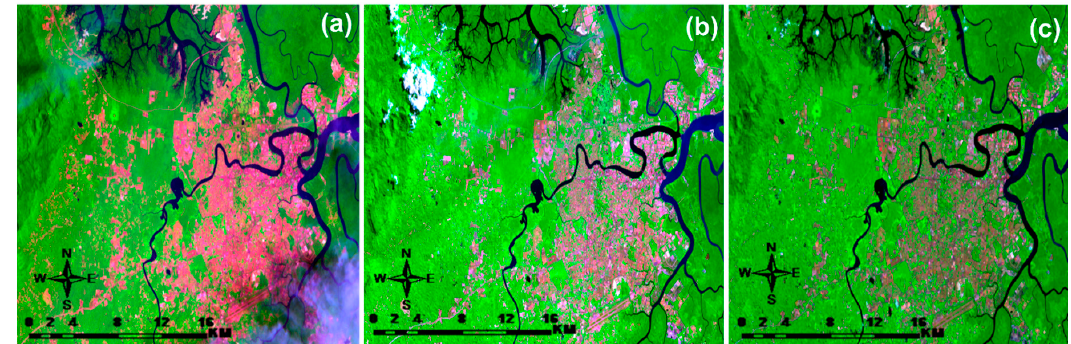
Figure 3. The phase of creating a seamless mosaic product from individual Landsat image; ( a ) Landsat-8 OLI, 10 June 2018; ( b ) Landsat-8 OLI, 18 June 2018; and ( c ) 2018 cloud-free Landsat Image over Kuching, Sarawak